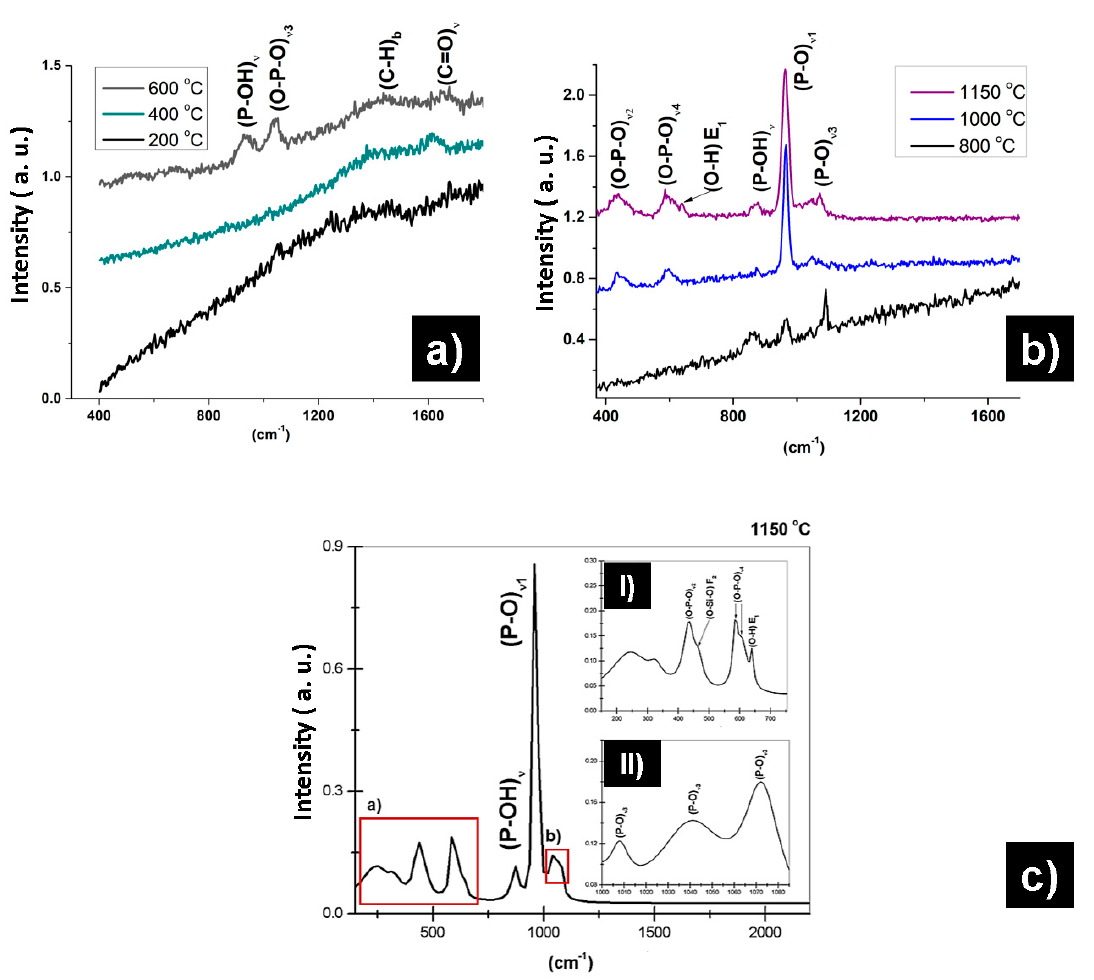
Figure 2. ( a ) Raman spectra of the SiO 2 –HA–PVP fibers from 50 to 400 °C, ( b ) Raman spectra of